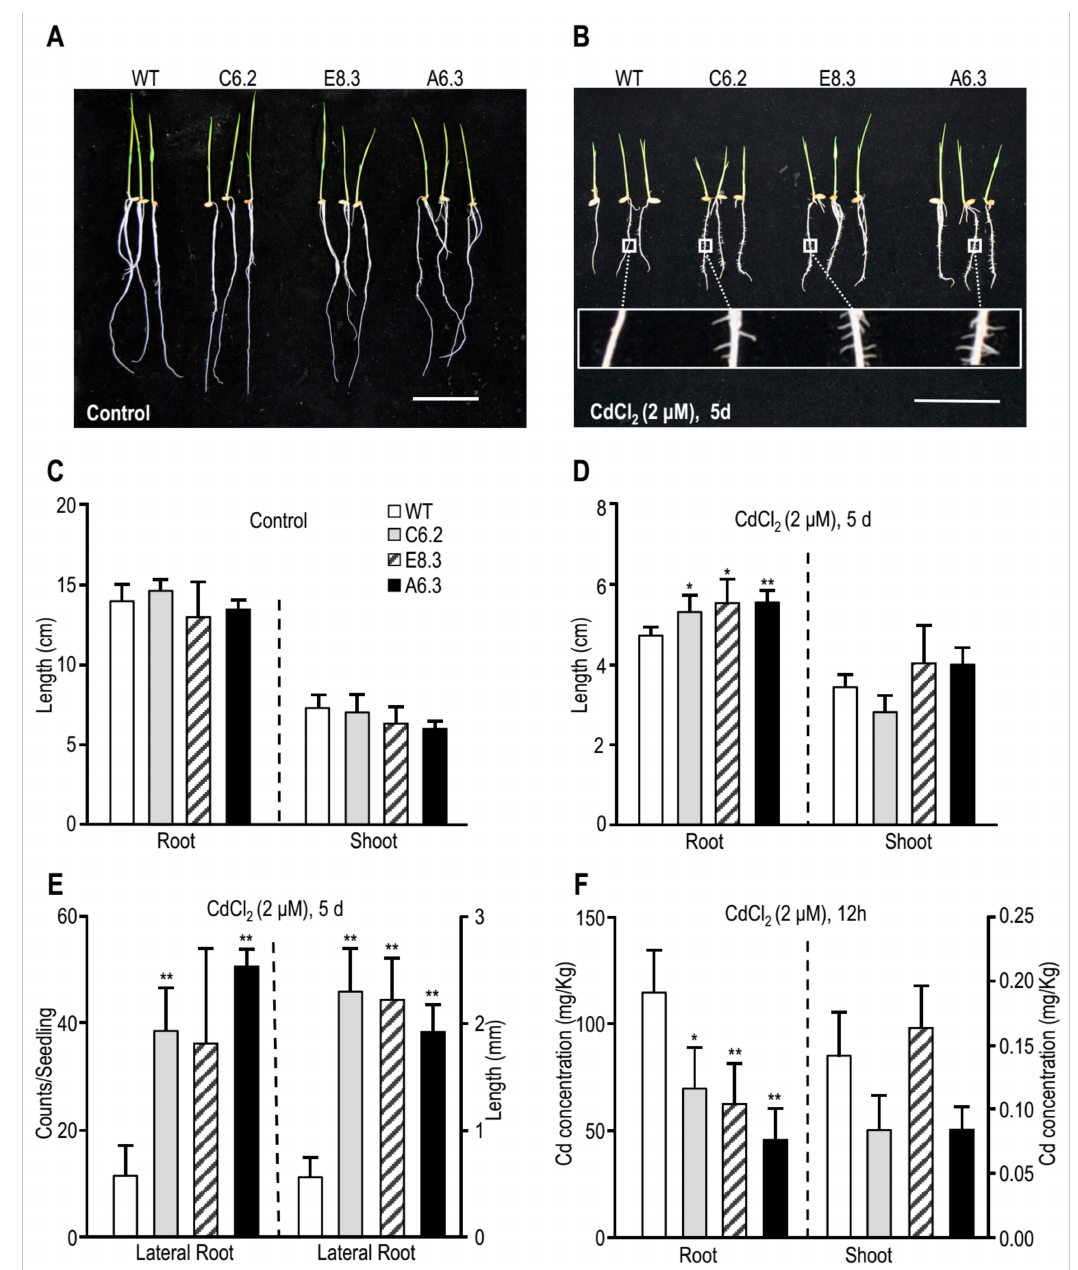
Figure 5. Expression of OsABCG48 confers tolerance to Cd and lowers Cd accumulation in T2 rice. Two-day-old T2 seedlings from T1 lines (C6.2, E8.3, A6.3) were grown in 1/2 Kimura B solution (pH 5.6) for 5 days ( A ) without Cd or ( B ) with 2 µ M Cd, with insert showing 4-fold magnified view of lateral roots from primary roots 2 cm from root tip. ( C , D ) Root and shoot lengths recorded from ( A ) and ( B ), respectively. ( E ) Number and length of lateral roots derived from primary roots shown as the insert in ( B ). ( F ) Cd accumulation in 28-day-old T2 seedlings from T1 lines (C6.2, E8.3 and A6.3) treated with 2 µ M Cd for 12 h. Data (bar and error bar) are shown as mean ± SD ( n = 3 for root length and Cd concentration, and 15 for lateral roots length); statistical analysis by unpaired Student’s t -test compared to WT (* p < 0.05, ** p < 0.01); scale bar = 5